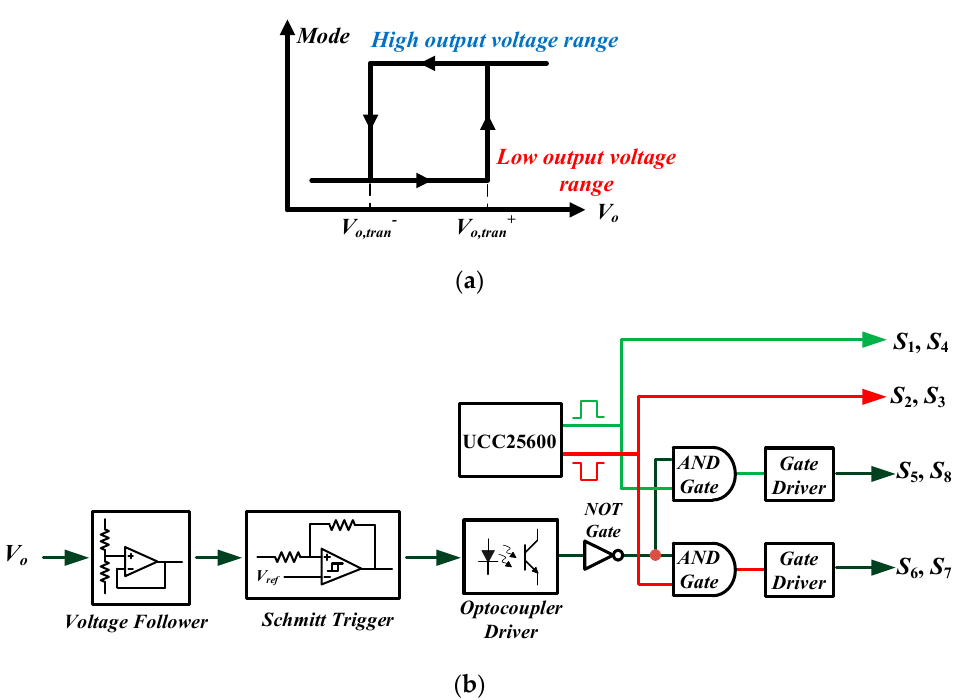
Figure 5. Control block of voltage transition operation. ( a ) Schmitt comparator; and ( b ) control block of signals S 1 ~ S 8 .